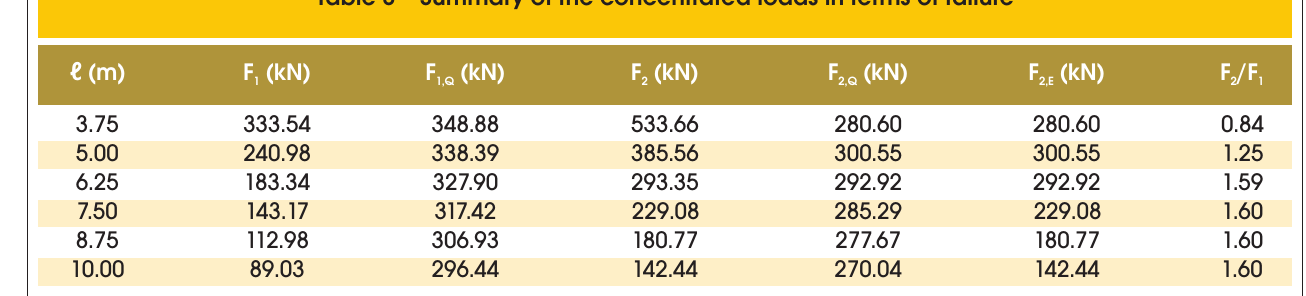
Table 8 – Summary of the concentrated loads in terms of